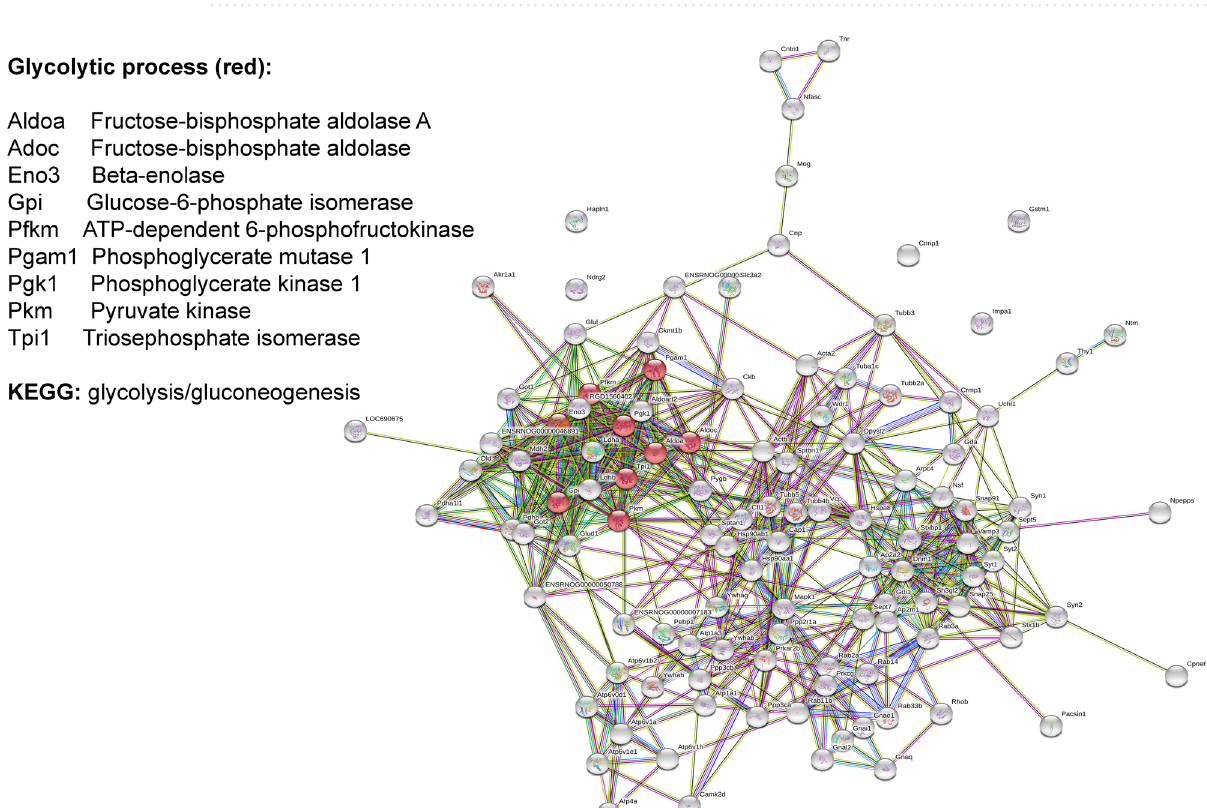
Figure 2. STRING-based interactome map of interactions among differently up-regulated synaptosomal proteins in Tian-treated Controls with, the corresponding GO Biological process terms.